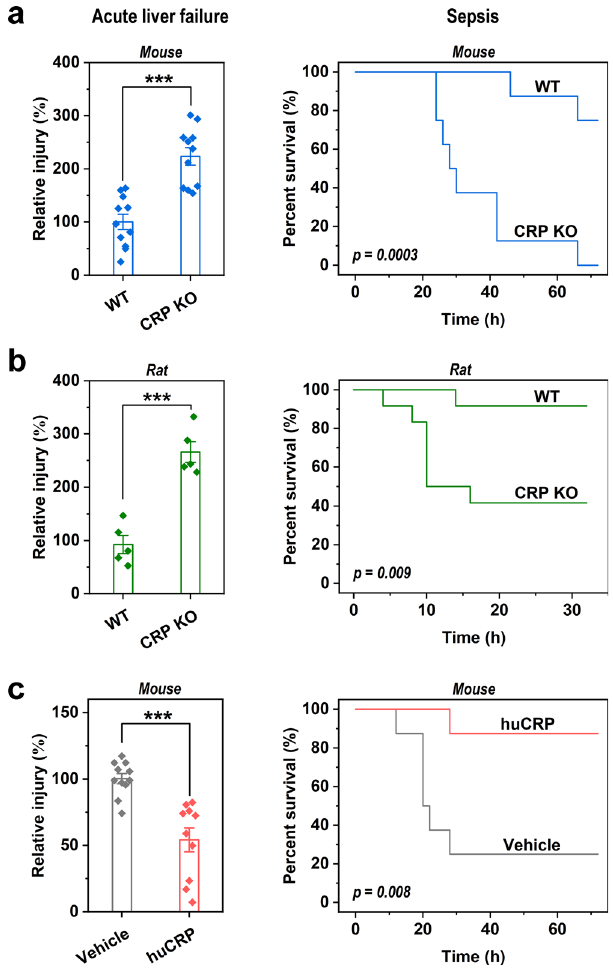
Fig. 1 In vivo functions of CRP are evolutionarily conserved. Acute liver failure ( n = 11 mice/group; n = 5 rats/group) and sepsis ( n = 8 mice/group; n = 12 rats/group) were induced in wild-type and CRP KO mice ( a ) or rats ( b ) by i.p. injection of acetaminophen or LPS. c Human CRP (huCRP) was administrated into wild-type mice with acute liver failure ( n = 11 for vehicle; n = 10 for huCRP treatment) or sepsis ( n = 10 mice/group). CRP KO aggravated, whereas huCRP administration alleviated both diseases. These results reveal consistent in vivo functional phenotypes of mouse, rat, and human CRP. Data are presented as mean ± SEM; *** p < 0.001, two-tailed Student ’ s t test,